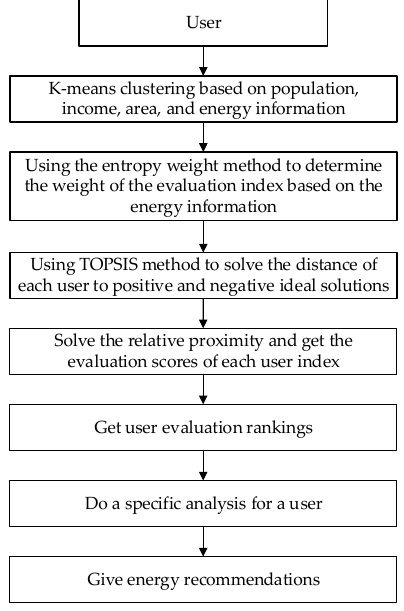
Figure 5. Resident user energy efficiency assessment process.